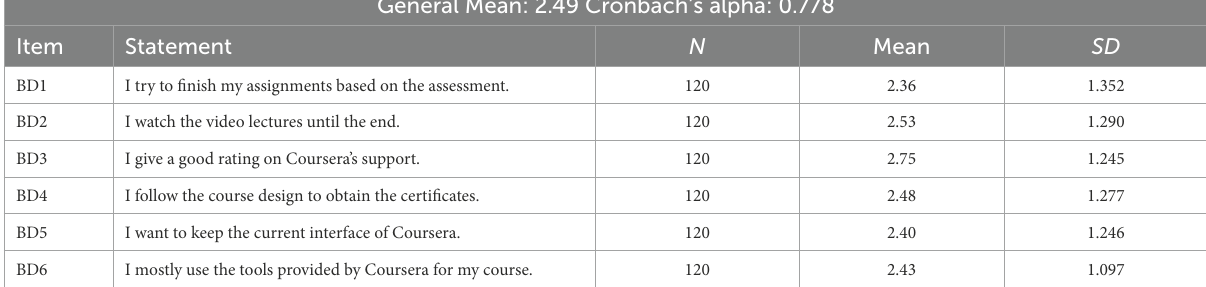
TABLE 2 Statistics for behavioral dimension.